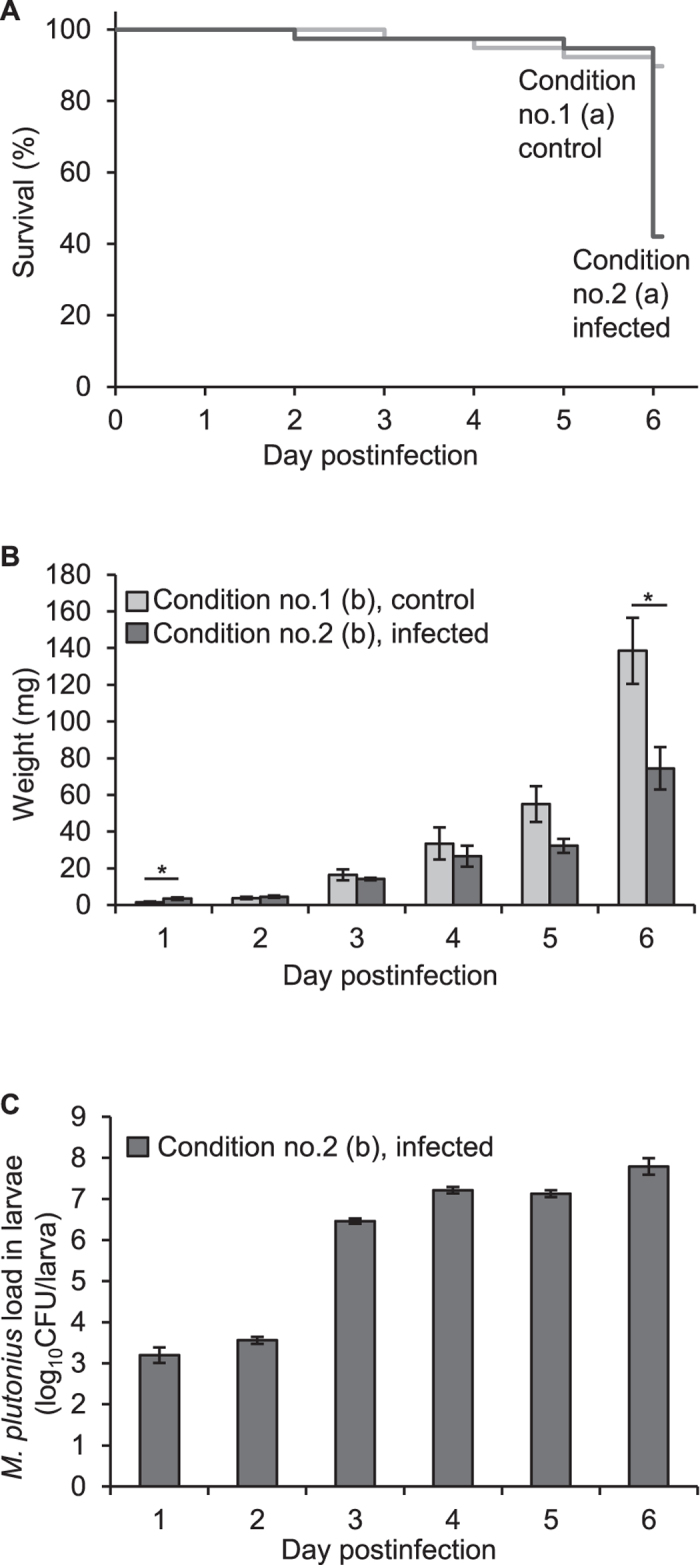
Virulence of M. plutonius strain DAT606(CC3) under the previously reported conditions (experimental condition nos 1 and 2). (A) Survival of control and infected larvae. Larvae in the infected group (no. 2) were fed with 10-μl Day 0 diet containing M. plutonius DAT606(CC3) at a final concentration of 1.7 × 107 CFU/ml (Supplementary Table S1). Survival rates of the control group at days 5 and 6 pi were 92.3% and 89.7%, respectively. Survival rates of the DAT606(CC3)-infected group at days 5 and 6 pi were 94.7% and 42.1%, respectively. (B) Larval weight presented as mg (mean ± SEM). Larvae in the infected group (no. 2) were fed with 10-μl Day 0 diet containing M. plutonius DAT606(CC3) at a final concentration of 1.4 × 107 CFU/ml (Supplementary Table S1). Five larvae were randomly selected from each group daily and weighed. The larvae were also used for determination of bacterial loads in the larvae. Asterisks indicate a significant difference between control and DAT606(CC3)-infected groups (two-tailed Student t-test, P < 0.05). (C) Bacterial loads in infected larvae calculated by real-time PCR and presented as log10CFU/larva (mean ± SEM). Total no. of larvae used for each experiment is shown in Supplementary Table S1.